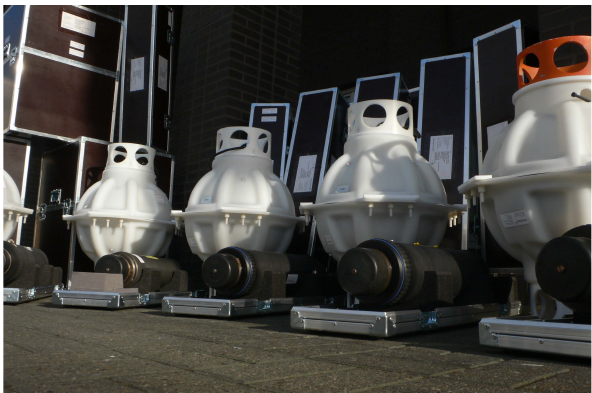
Fig. 13. 5 PACT Bottom Units in “hard hat” protective housing (white) with Ham-Node Modems (olive) ready for shipping to In- donesia. Shipping boxes (brown with aluminium rims) are visible in the